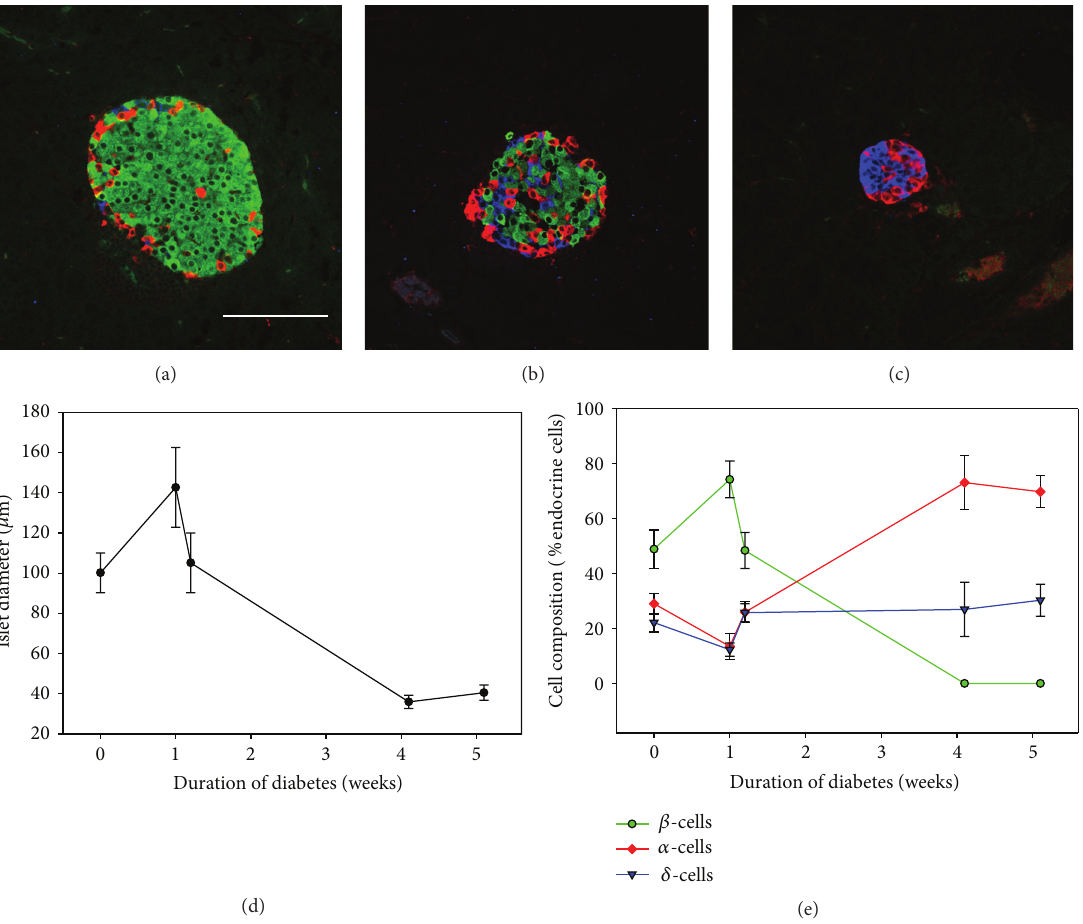
Figure 5: Islet size and cell composition in NOD mice. (a) Islets from NOD mouse that did not develop hyperglycemia were immunostained for 𝛽 -cells (green), 𝛼 -cells (red), and 𝛿 -cells (blue). Scale bar—100 𝜇 m for all images. (b) Islet from an NOD mouse diabetic for 1 week. (c) Islet from an NOD mouse diabetic for 3 weeks. (d) Because the onset of hyperglycemia was extremely variable in the NOD mice, islet diameter was plotted according to the duration of diabetes. Islet diameter decreased with increasing duration of diabetes. (e) Cell composition was also plotted according to the duration of hyperglycemia. With increasing duration of diabetes, 𝛽 -cells were lost and 𝛼 -cell numbers increased. 𝑁 for both graphs = 11.803 cells from 116 islets from 6